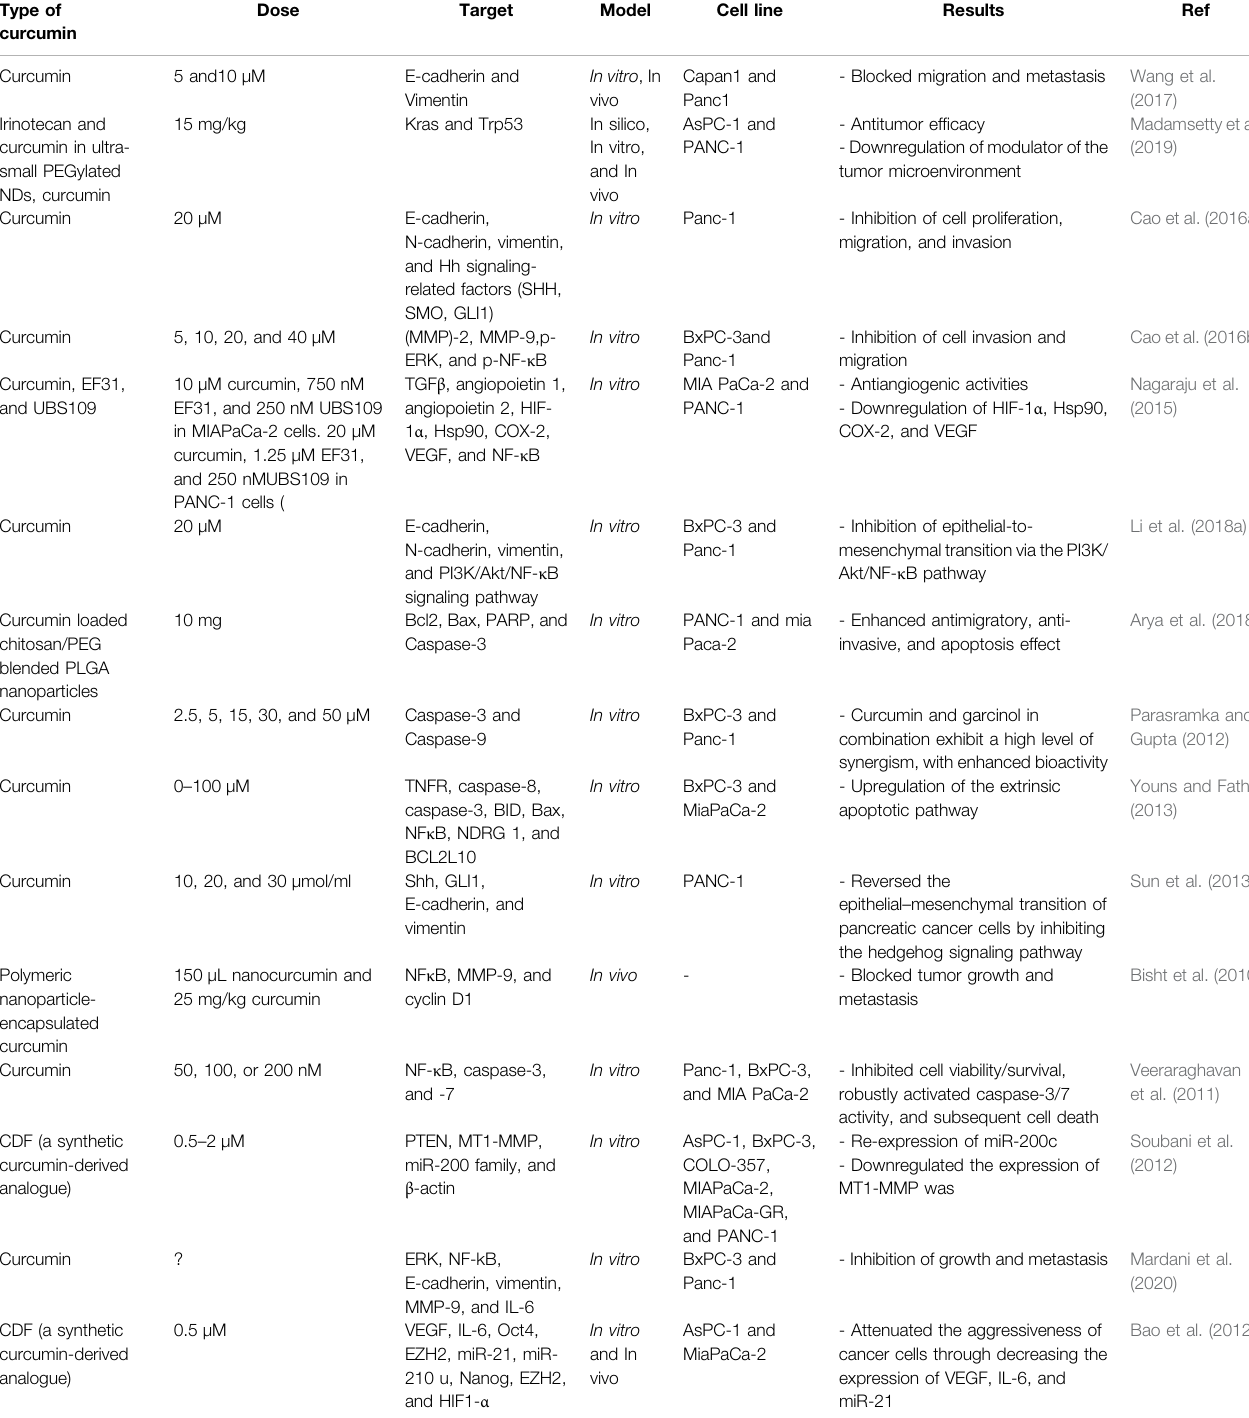
TABLE 1 | Curcumin and metastasis in pancreatic